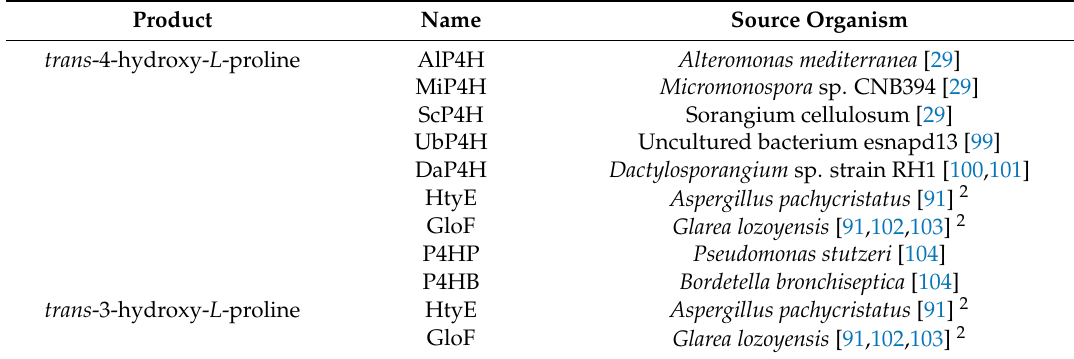
Table 1. List of proline hydroxylases classified according to their substrate preference (not